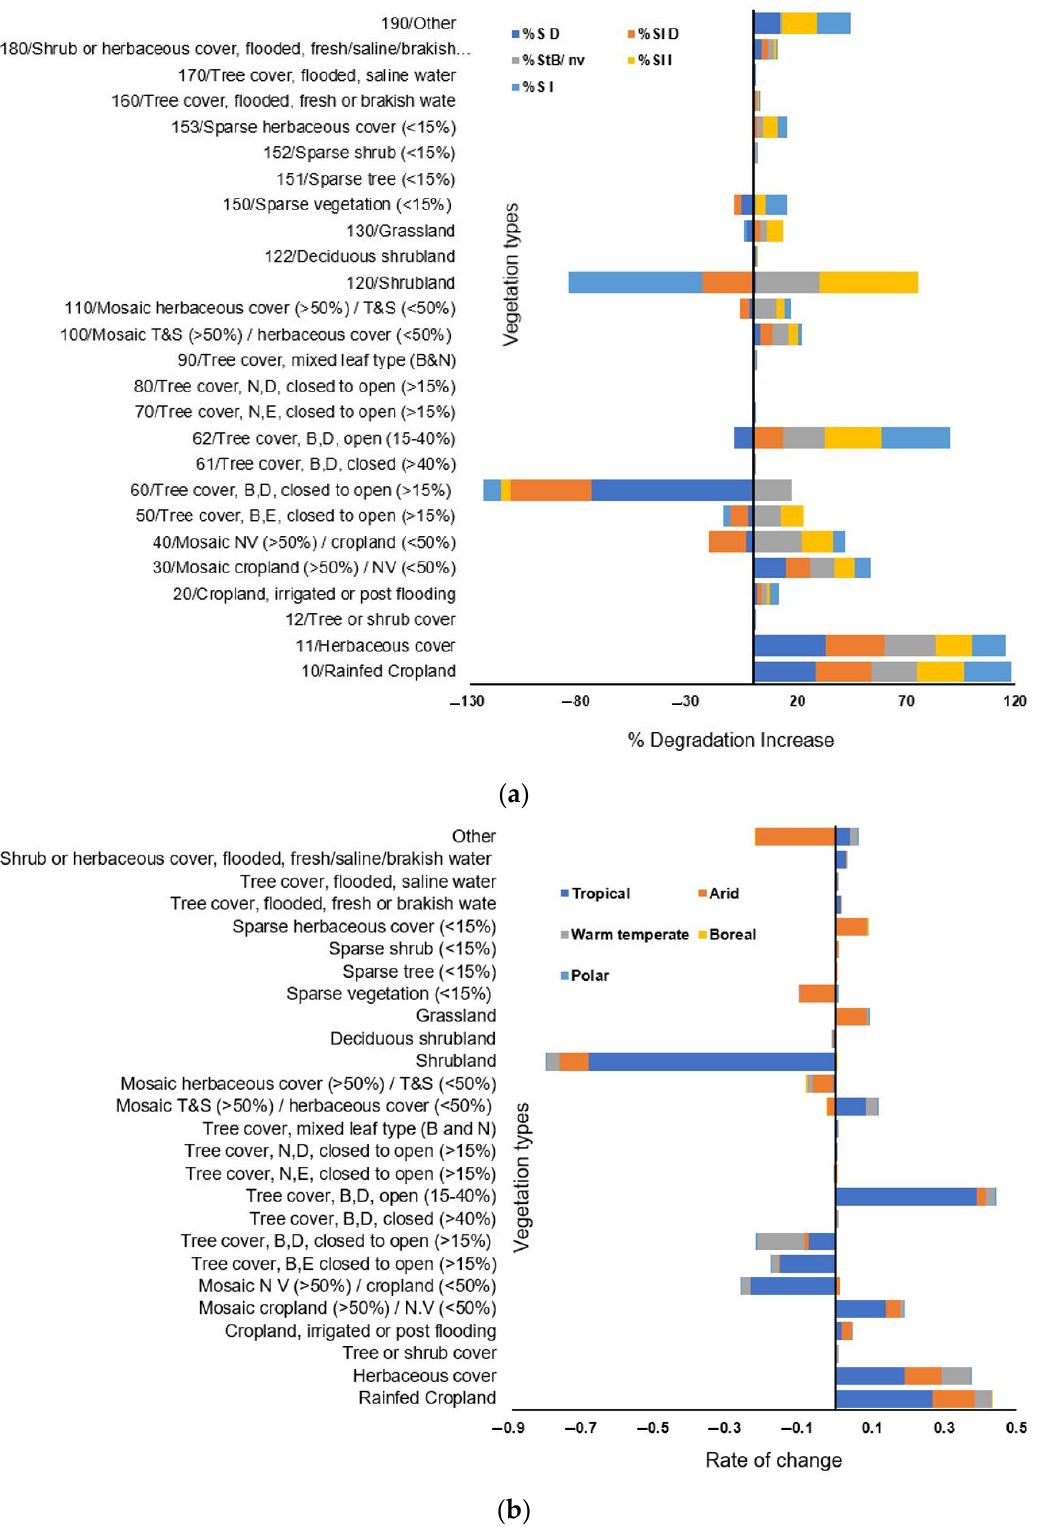
Figure 7. Chart of Vegetation Change ( a ) trends in % and ( b ) rate of change from 1992 to 2015. With, %S D: is % of Strong degradation, %SI D: % of Slight degradation, %StB/nv: % of Stable or non-vegetation, %Sl I: % of Slight Improvement, %S I: % of Strong Improvement. Where, NV: natural vegetation; B, E: broadleaved, evergreen; B, D: broadleaved, deciduous; N, E: needle leaved, evergreen; N, D: needle leaved, deciduous; B & N: broadleaved and needle leaved; T&S: tree and shrub. Other (Urban areas, Bare areas, Consolidated bare areas, Unconsolidated bare areas, Water